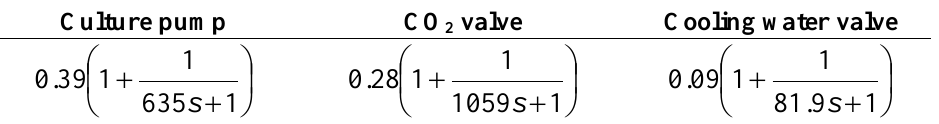
Table B2. Transfer functions of the PI